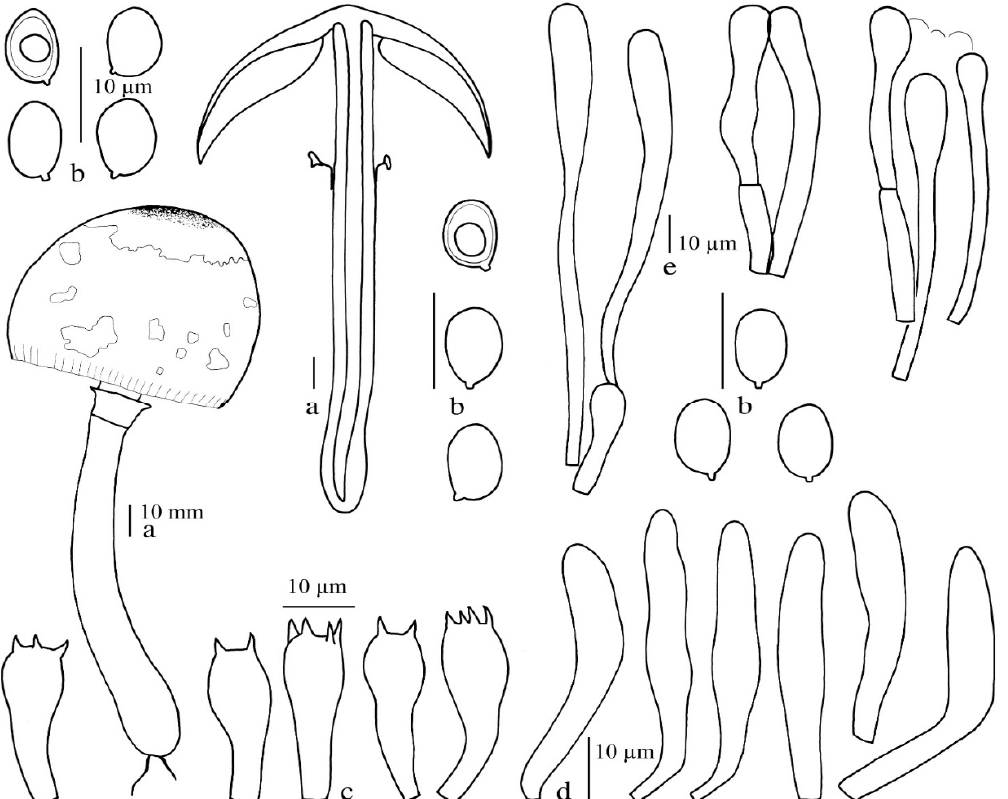
Figure 6. Chlorophyllum demangei (ecv3622). ( a ) Basidiomata. ( b ) Basidiospores. ( c ) Basidia. ( d ) Cheilocystidia. ( e ) Pileus covering elements.